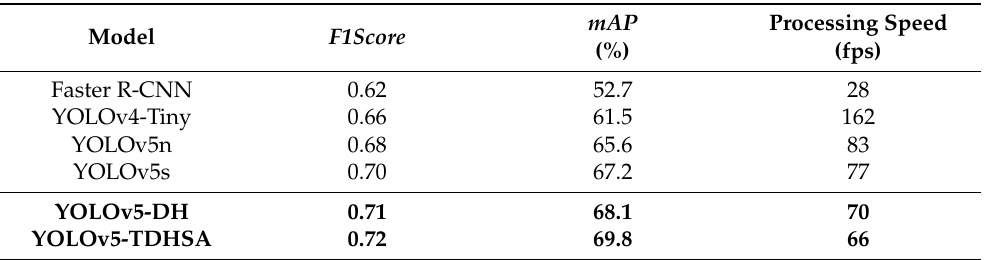
Table 18. Results of compared models on CCTSDB2021